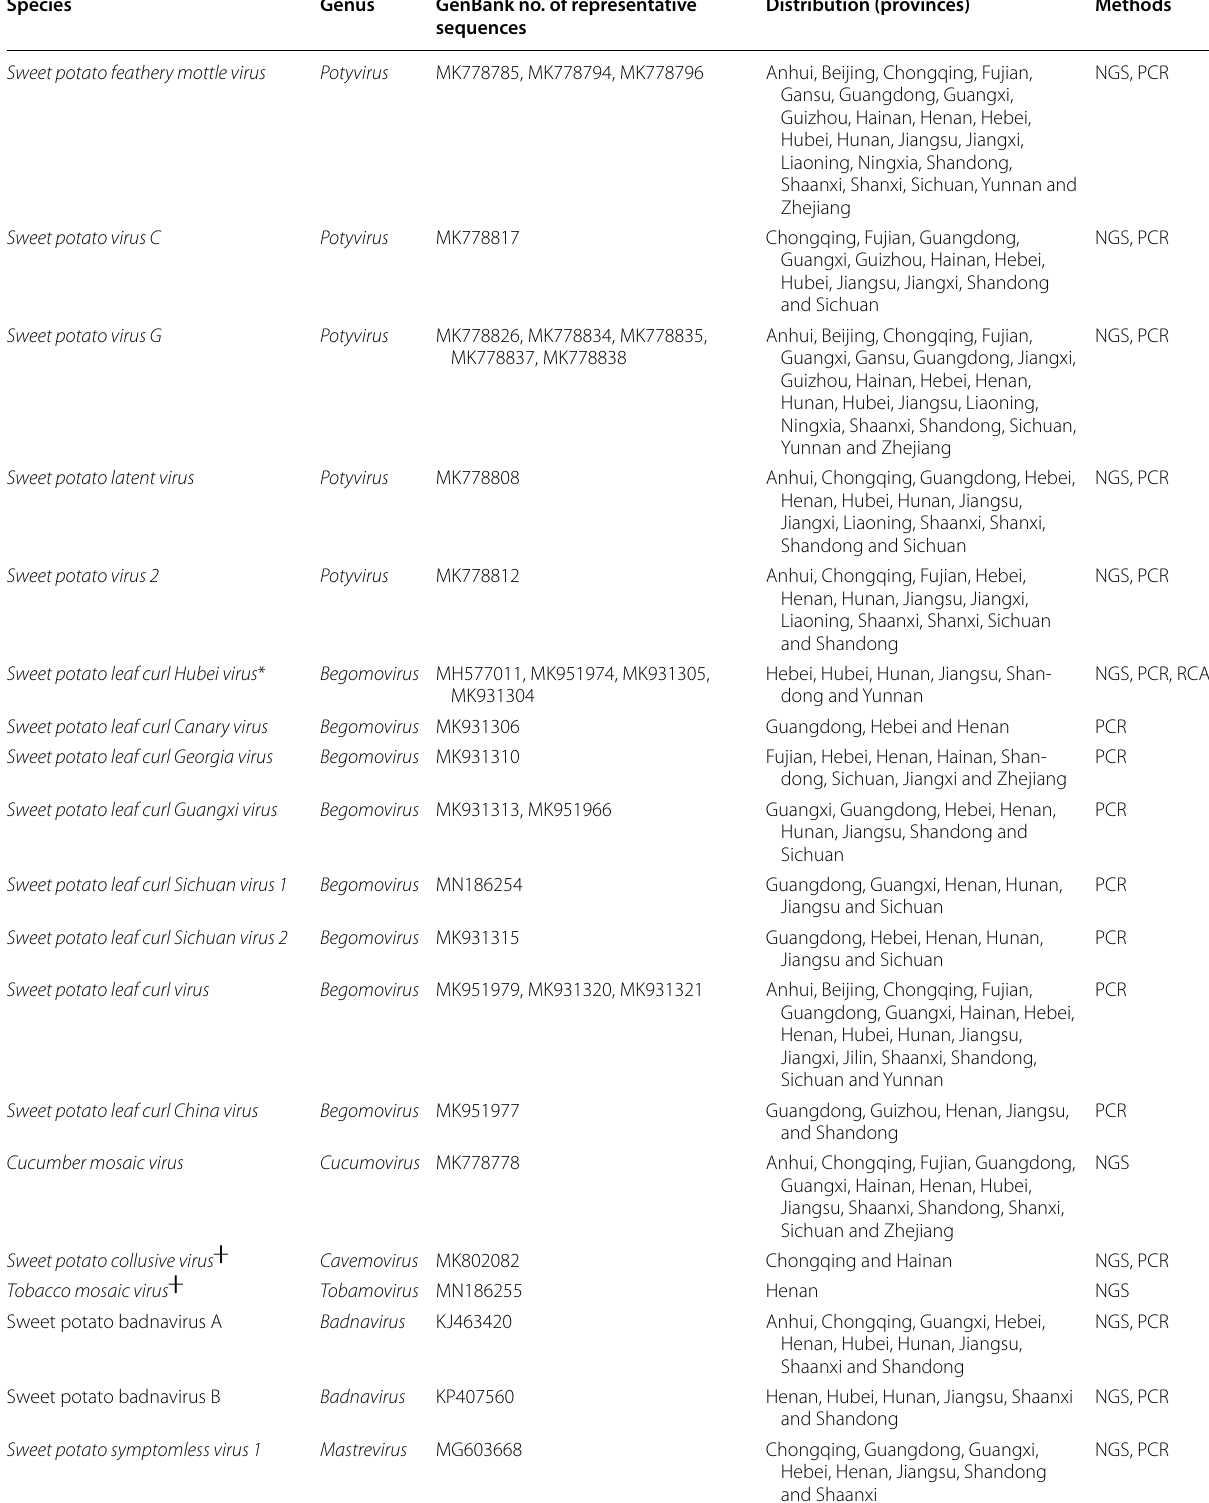
Table 1 Sweet potato virus species and their distribution in China Species Genus GenBank no. of representative Distribution (provinces) sequences